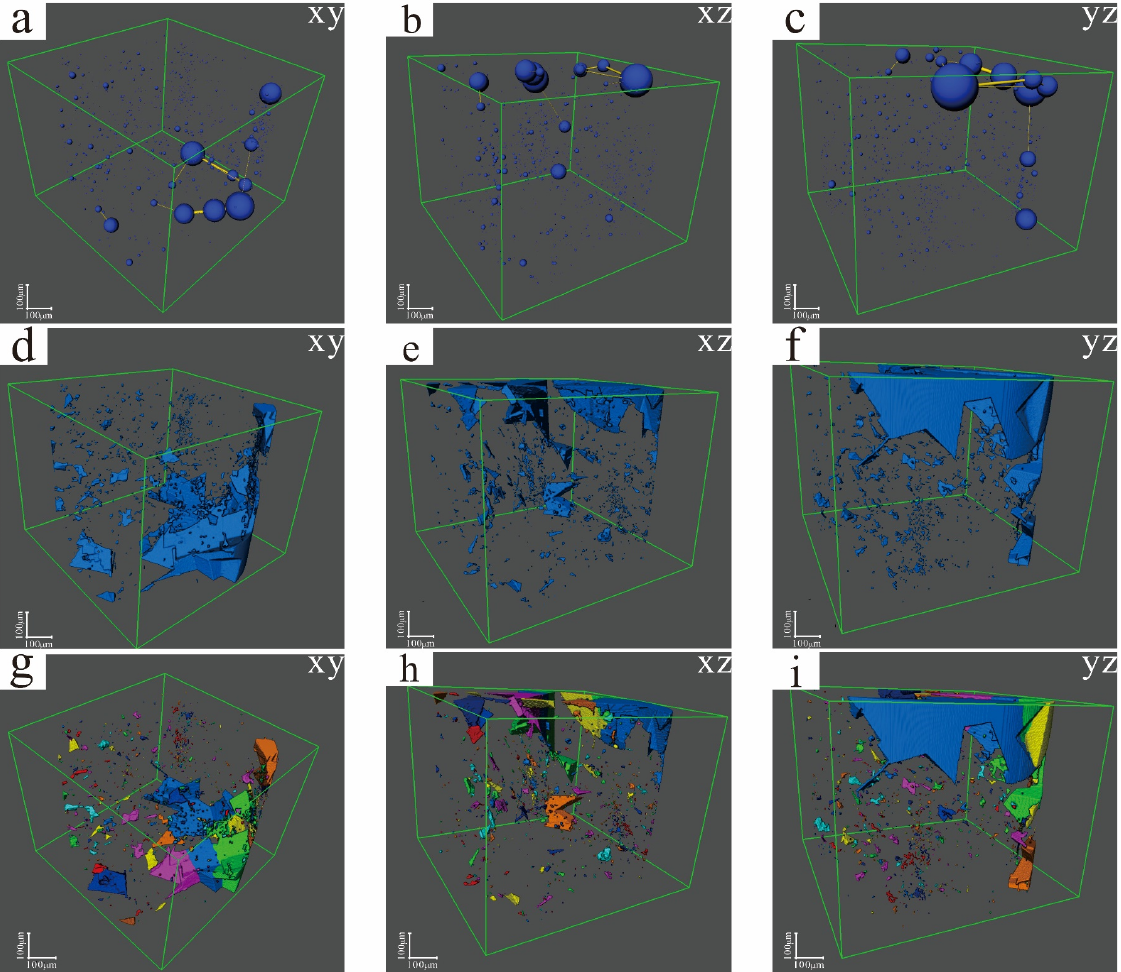
Figure 15. Pore and pore throat structure imaging of sample HZ-12: ( a – c ) the blue spheres represent the pores, and the yellow lines represent the pore throats; ( d – f ) blue represents the spatial position of the pores and pore throats; ( g – i ) the pores with similar colors in adjacent regions are connected. The micro-CT scan of sample HZ-14 is shown in Figure 16, where the black part represents the pores, and the gray part represents the rock matrix. The pores of HZ-14 were generally small and